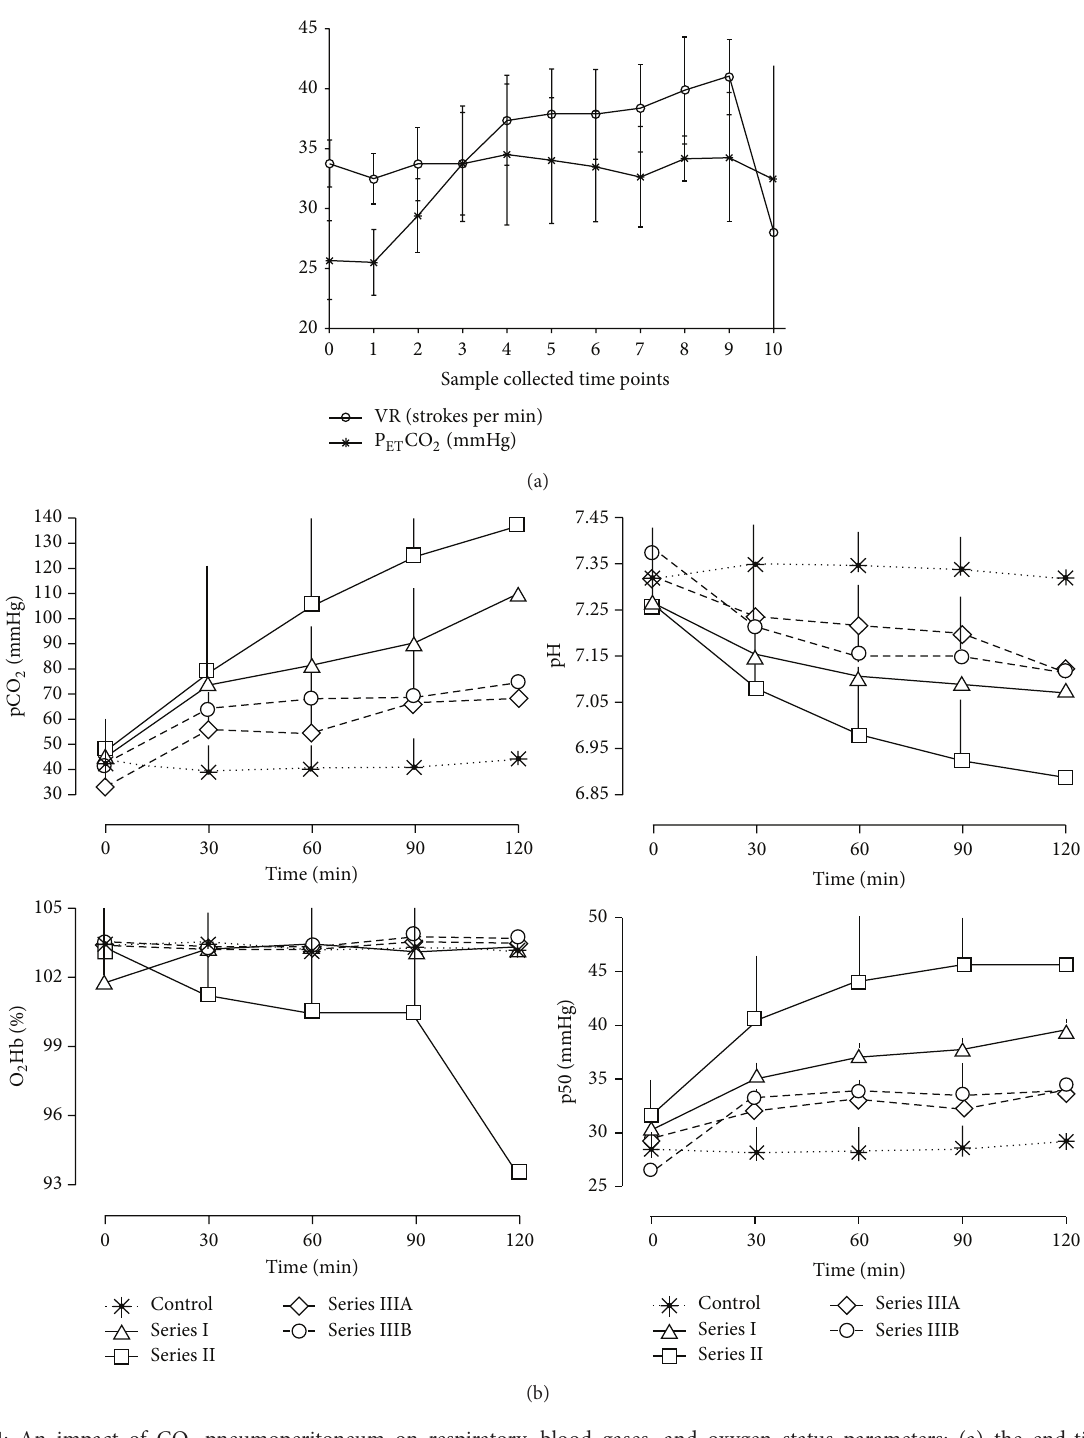
Figure 1: An impact of CO 2 -pneumoperitoneum on respiratory, blood gases, and oxygen status parameters: (a) the end-tidal CO 2 concentration (P ET CO 2 ) and ventilation rate (VR) parameters in 12 newborns, suffering laparoscopic surgical procedures due to ovarian tumors, at the time of induction (0), at the time of incision (1), and every 10 minutes during (2–9) and after (10) laparoscopic surgery with CO 2 -pneumoperitoneum at 7–9 mmHg (eleven sampling points) from [2], unpublished data); (b) an arterial blood carbon dioxide partial pressure(pCO 2 ),pH,oxyhemoglobin(O 2 Hb),andoxygentensionathalfsaturationassessingthehemoglobinoxygenaffinity(p50):inrabbits without pneumoperitoneum (control), spontaneously breathing animals (series I), superficially ventilated animals (series II), and optimally ventilated animals with insufflation pressures of 10mmHg (series IIIA) or 6mmHg (series IIIB). Values are means ± SD (modified from